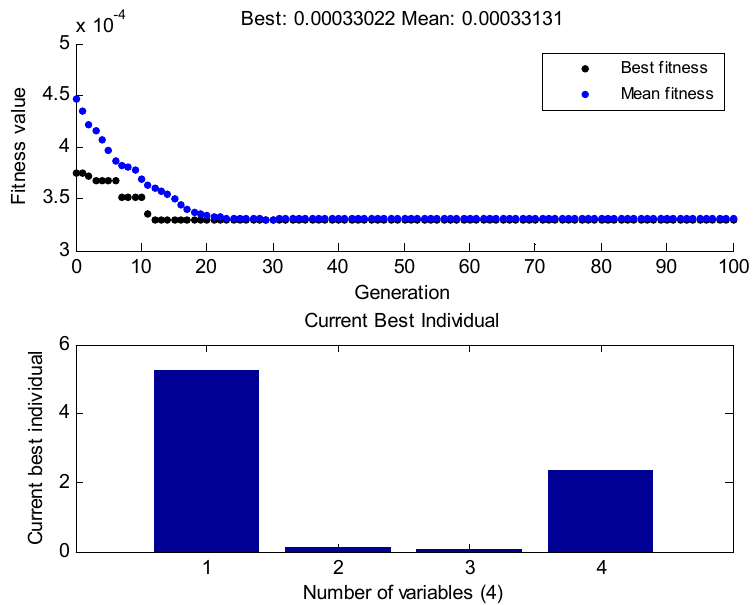
Figure 11. The convergence history of the fitness and the exact value for each variable.